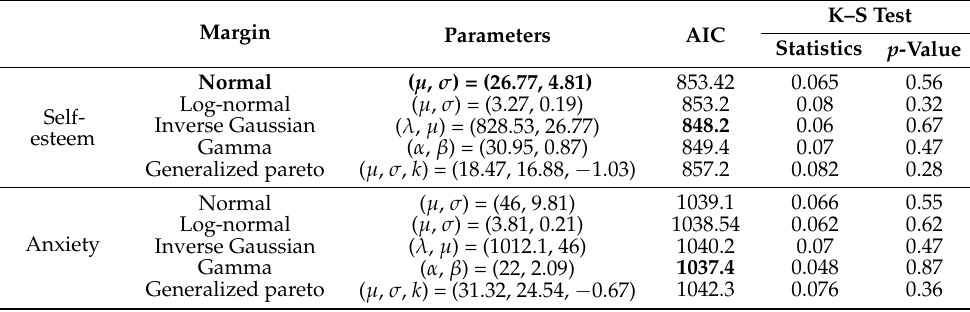
Table 3. Estimated parameters of marginal distributions fitted to the self-esteem and anxiety data.